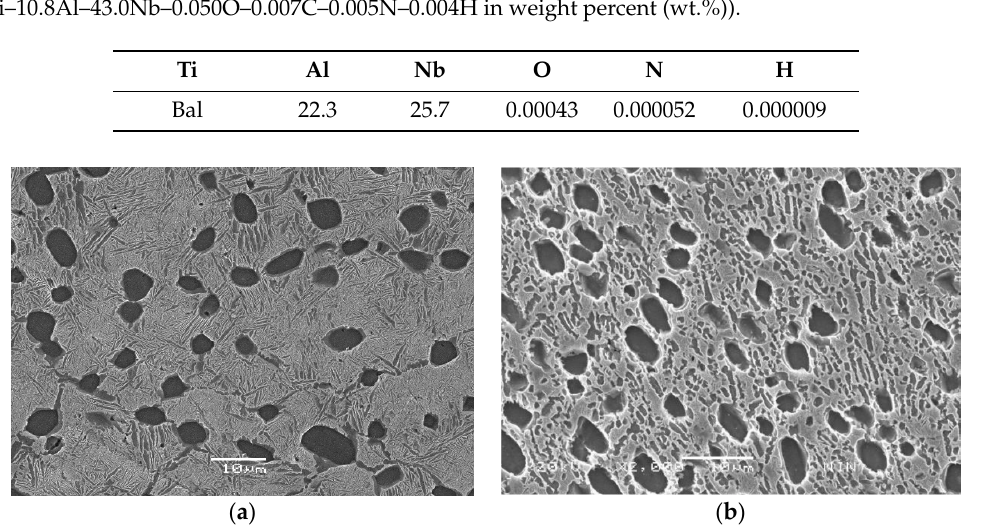
Table 1. Chemical composition of the Ti-22Al-25Nb alloy (at.%) (The true chemical composition of the alloy was measured with a chemical analysis method, which was Ti–10.8Al–43.0Nb–0.050O–